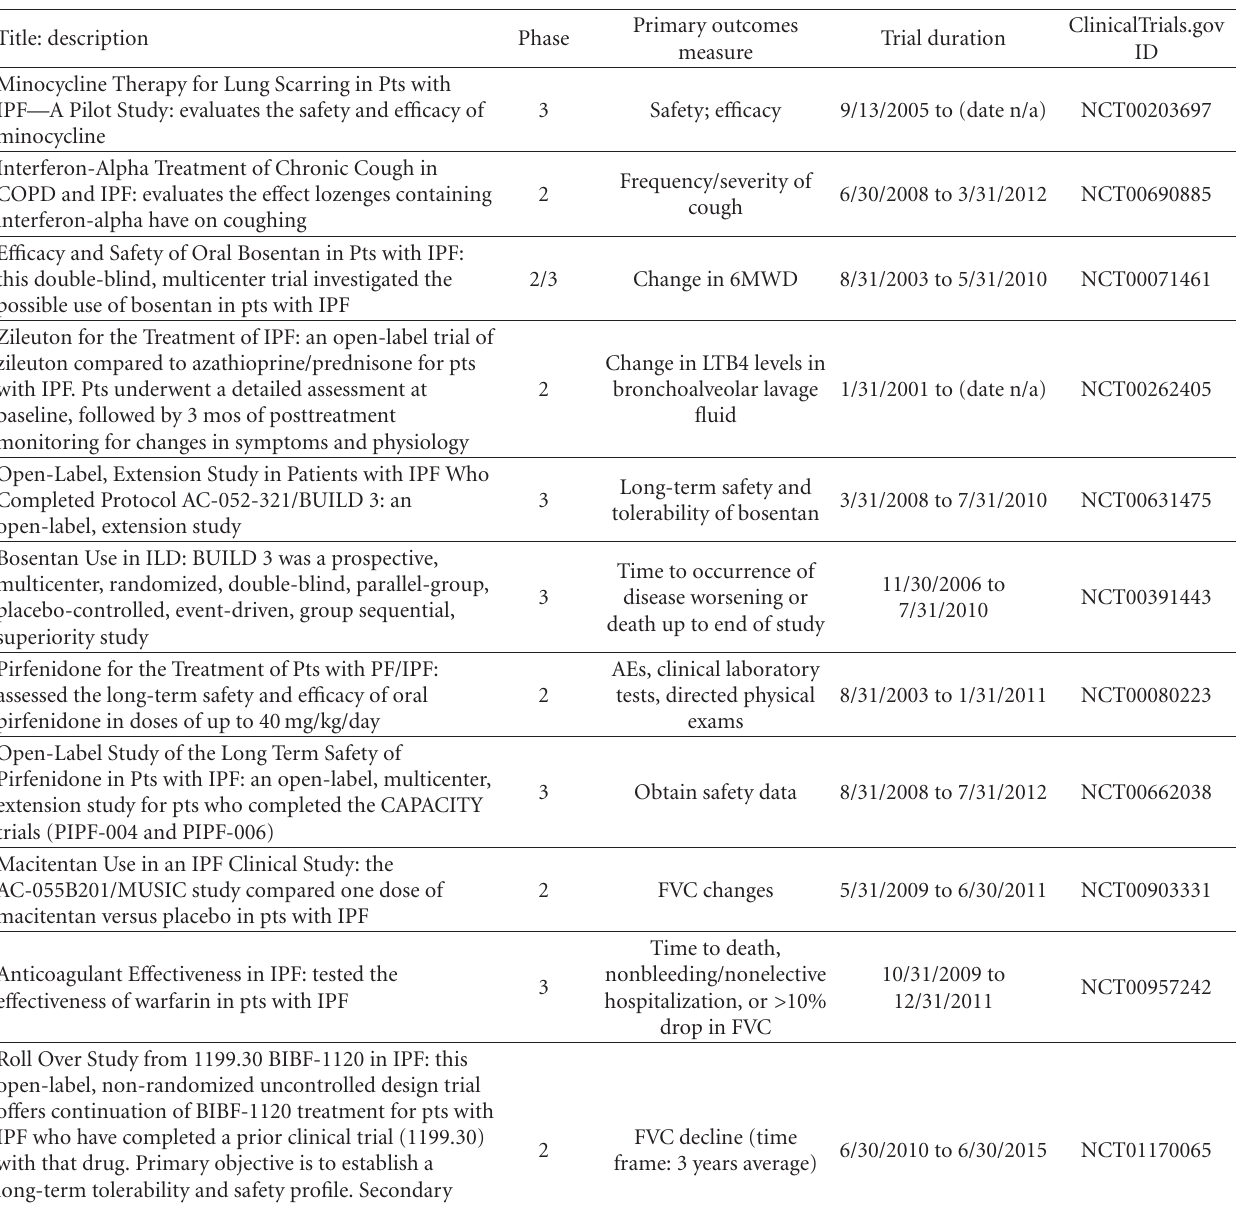
Table 1: Closed clinical trials in pulmonary